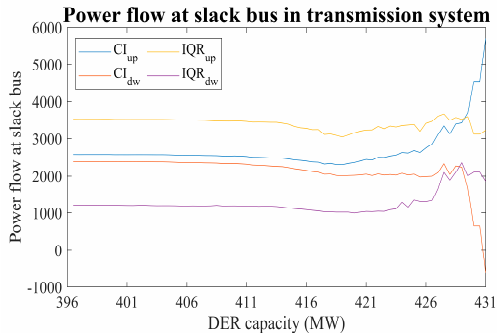
Figure 10. The result for the power flow in the transmission system.